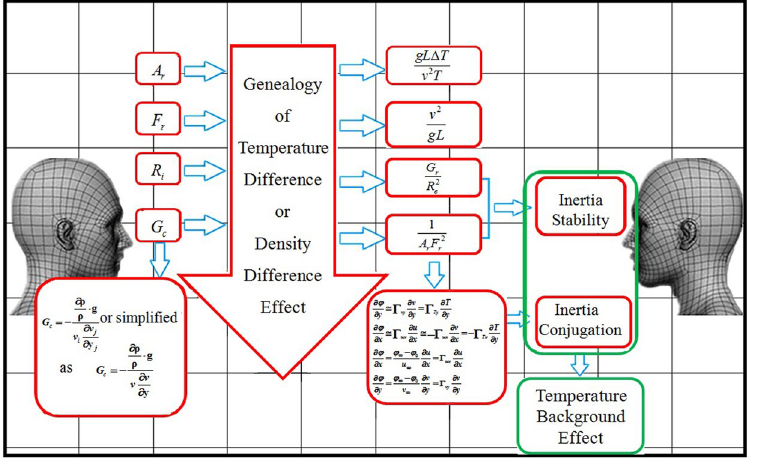
Figure 1. The genealogy of temperature difference or density difference effect. L is the height of test room, (m), v is the characteristic velocity of airflow, (m/s), T is average indoor temperature, (K), T t is temperature on the top of the room, (K), T b s temperature at the bottom of the room, (K), Δ T is the difference between T t and T b , (K), G r is Grashof number, R e is Reynold number, ρ is indoor average density (kg/L), C is the smoke concentration value (ppm), C ∞ and C 0 are smoke concentration around the outside research area and wall location (ppm), respectively, Γ ux and Γ vy are effective or equivalent diffusion coefficient of u along x and y direction, respectively, Γ Tx and Γ Ty are effective or equivalent diffusion coefficient of T along x and y direction, respectively, v i and v j are component velocity at i and j direction, respectively,